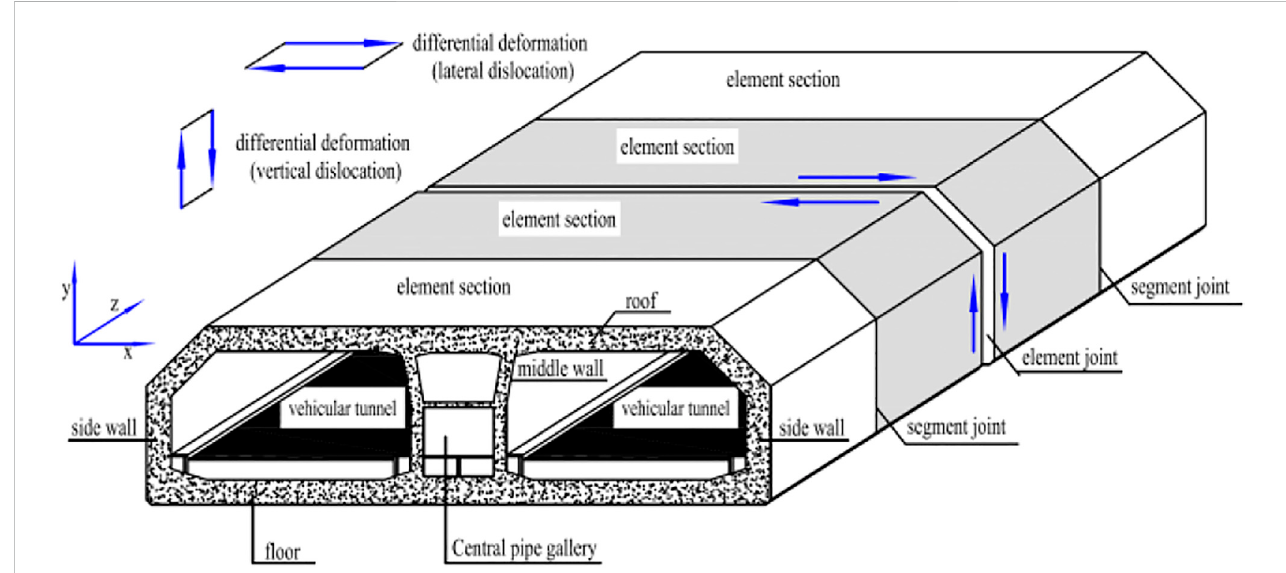
FIGURE 1 Schematic diagram of the differential deformation mode between the immersed tunnel model and the element